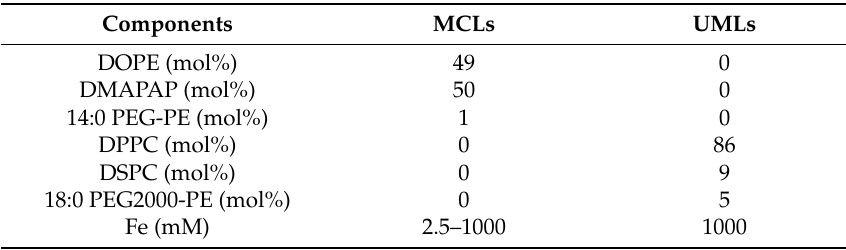
Lipid components and iron concentration for magnetic liposome formulations. DOPE: